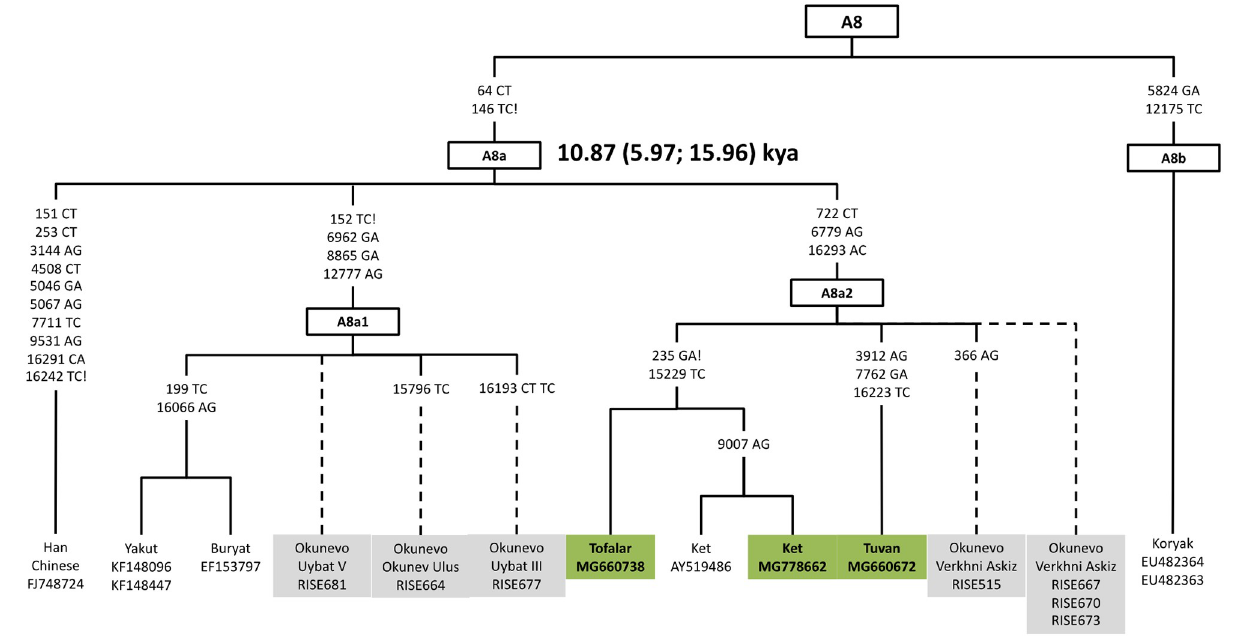
Fig 6. A phylogeny of A8 revealing distinct lineages or